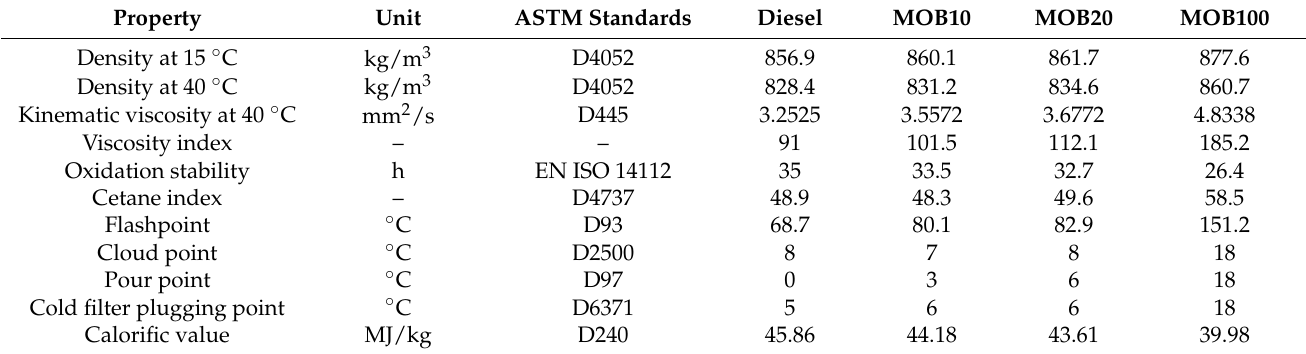
Table 3. Physicochemical characteristics of Moringa oleifera biodiesel and their